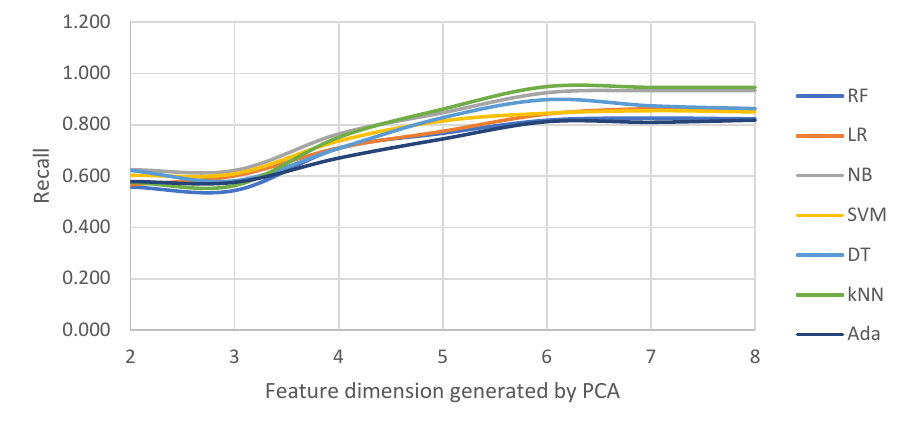
Fig. 14. Recall results for the comparison between different machine learning models using